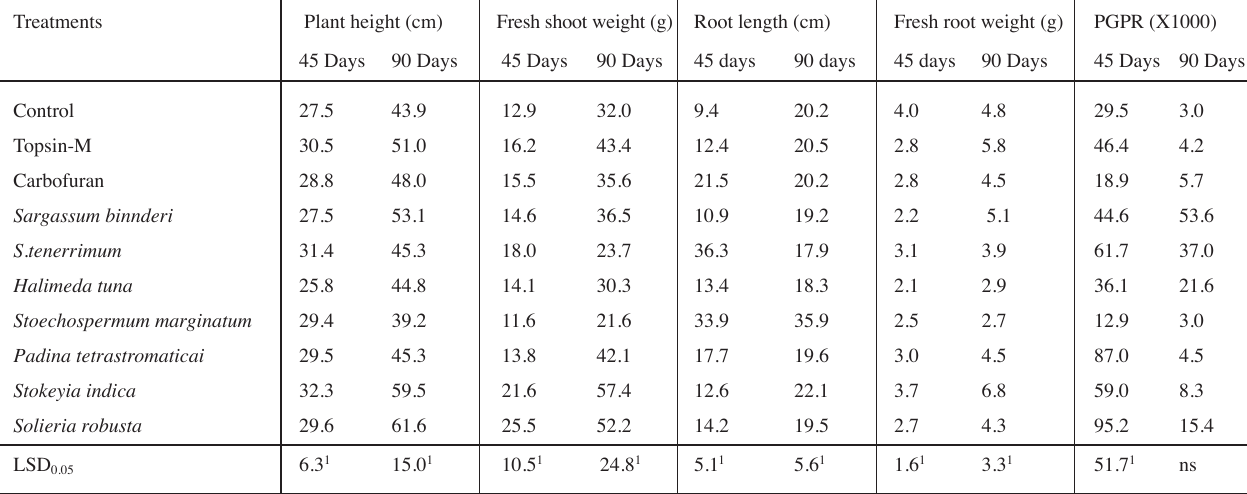
Tab. 6: Effect of seaweeds on the growth of pepper and population of rhizospheric fluorescent Pseudomonas (PGPR) in field experiment.